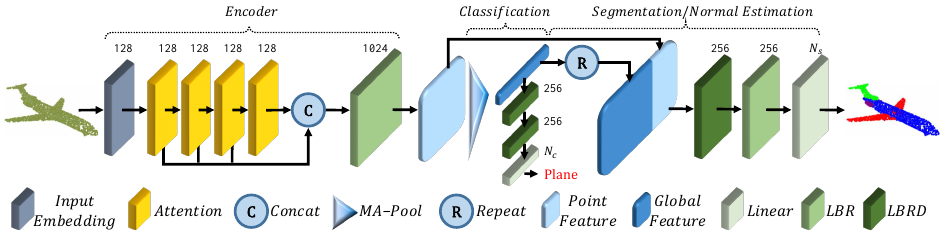
Figure 13. Point cloud transformer network architecture [83].